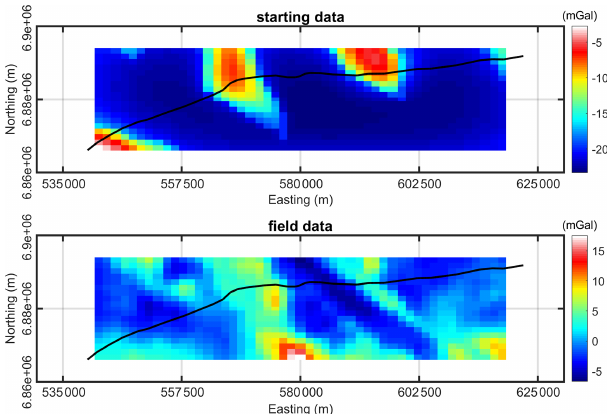
Figure 11. The starting and field gravity datasets of the Yamarna Terrane. Solid black lines represent the seismic